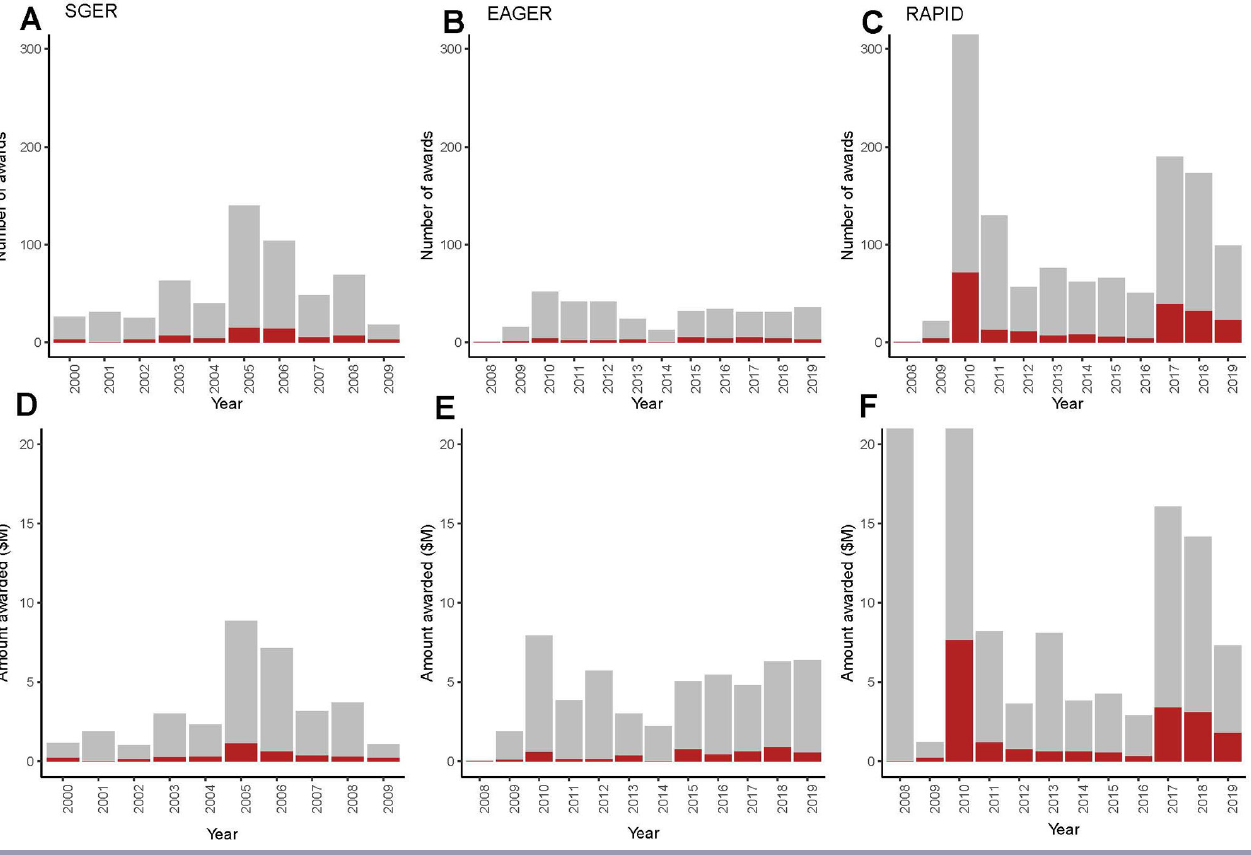
Fig. 5 . Estimated number and amount of SGER (A, D), EAGER (B, E), and RAPID (C, F) grants awarded by the U.S. National Science Foundation for disaster-related studies in general (gray) and specifically for ecological research (red) between 2000 and